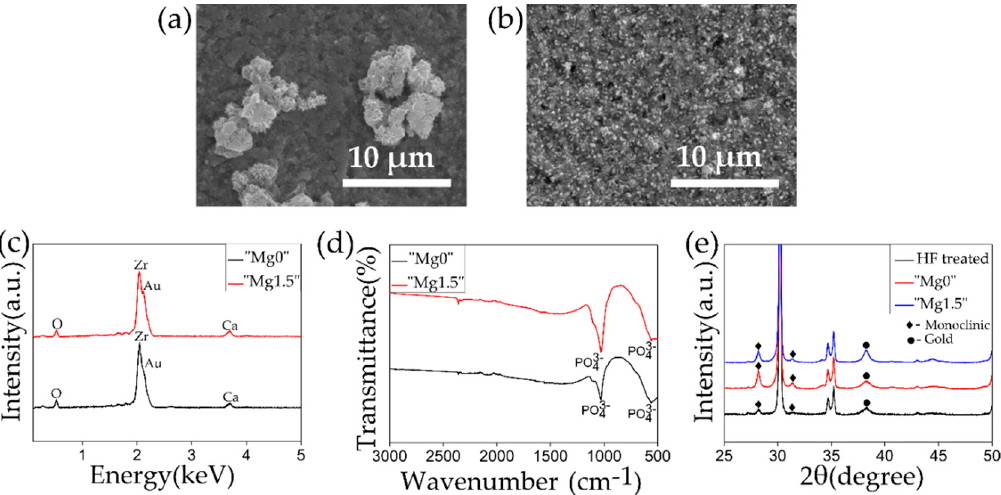
Figure 4. SEM images of HF-etched 3Y-TZP samples after ( a ) “Mg0” and ( b ) “Mg1.5” solution treatments. ( c ) EDX and ( d ) FTIR comparing properties of the HF-etched 3Y-TZP samples after “Mg0” or “Mg1.5” solution treatments. ( e ) XRD plots of HF-etched 3Y-TZP samples before and after “Mg0” or “Mg1.5” solution treatments.